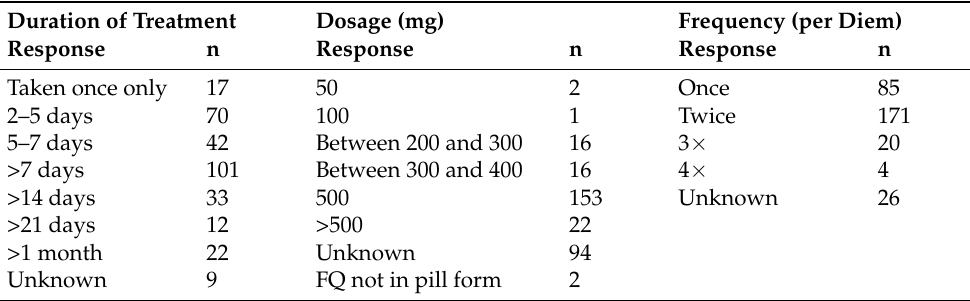
Table 3. Summary of the data collected from all survey respondents regarding the duration of their FQ treatment, dosage, and frequency (per diem) of